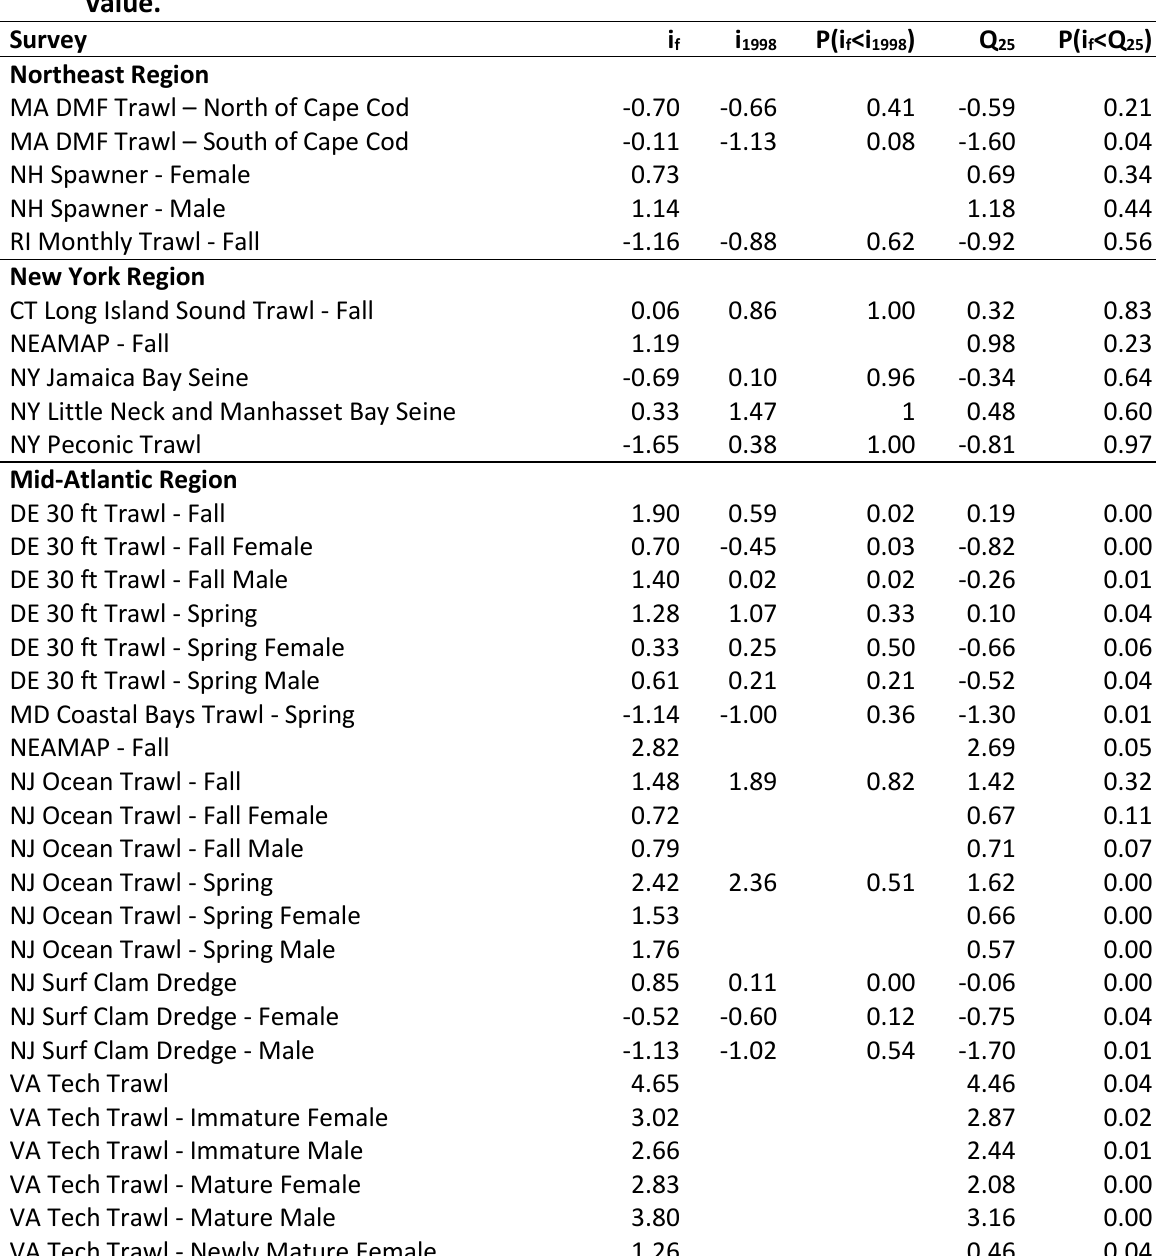
Table 39. Reference points from the ARIMA model for each survey and the probability that the terminal year's fitted index (i f ) is below the reference point. The 1998 reference is i 1998 and the lower quartile reference is Q 25 . Reference points are based on ln transformed index values. Surveys that began after 1998 do not have a 1998 reference